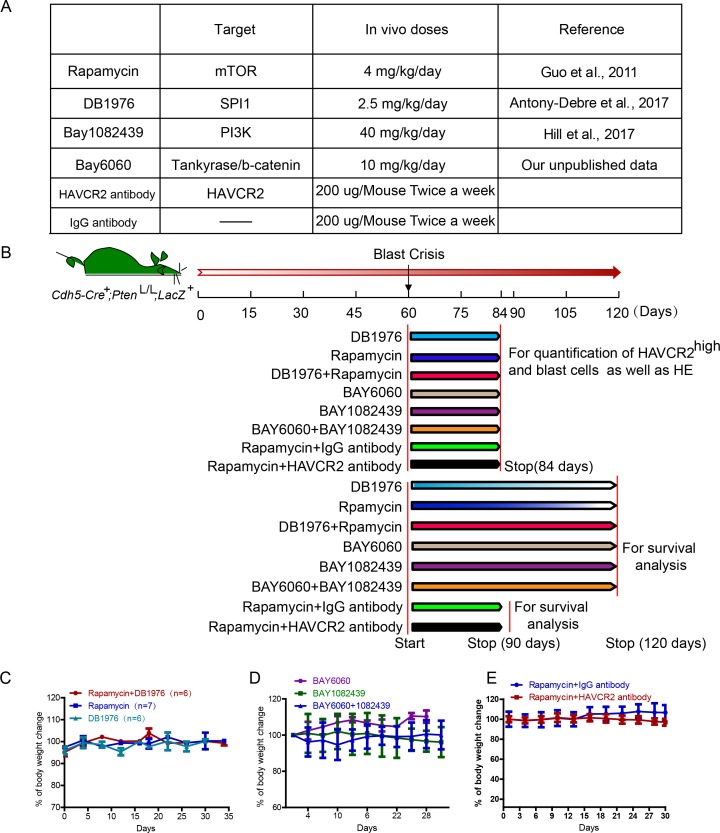
A schematic illustration of dosing schedules and treatment cohorts.(A) Table showing all inhibitors used in this study, including their targets, in vivo dosages and references. (B) Schematic illustration of the different treatment cohorts and analyses; (C– E) Lack of general body weight loss in each treatment cohort.